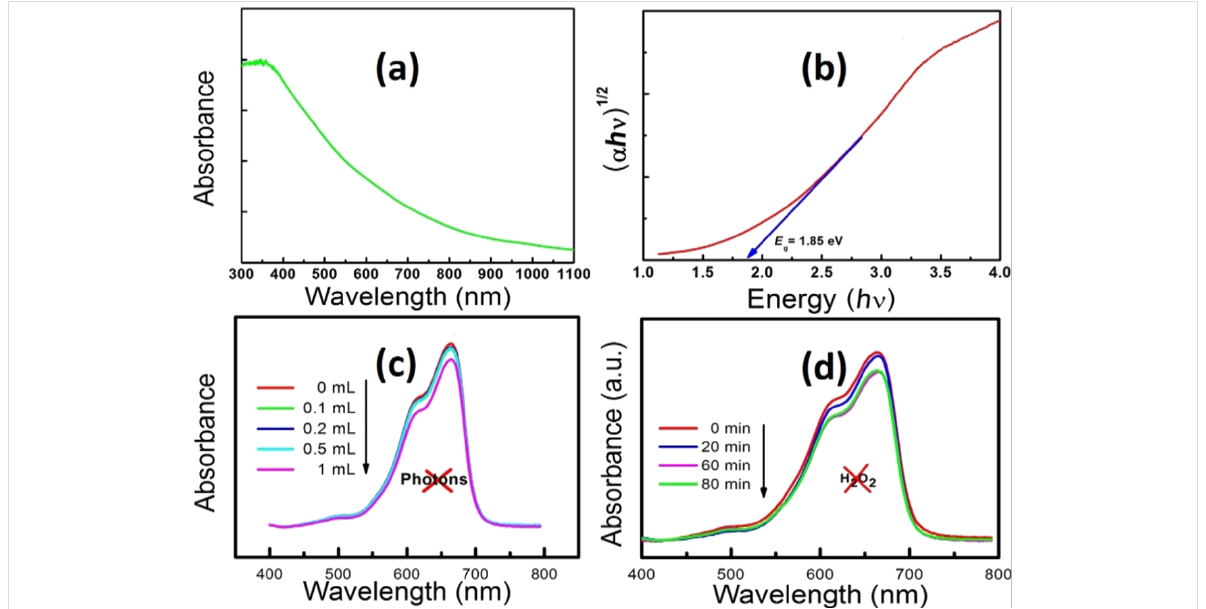
Figure 2: (a) UV–vis absorption spectra of CuO nanopetals. (b) Tauc’s plot for CuO nanopetals (c) UV–vis absorption spectra illustrating the effect of different concentrations of H 2 O 2 in methylene blue degradation in the absence of CuO nanopetals (catalyst) under dark conditions. (d) UV–vis absorp- tion spectrum of methylene blue degradation using CuO nanopetals as a photocatalyst for different